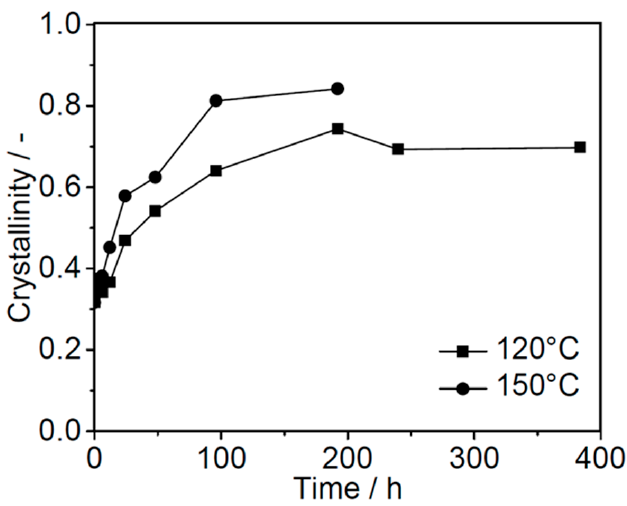
Figure 8. The development of apparent MFI crystallinity as a function of SAC time at 120 °C and 150 °C.